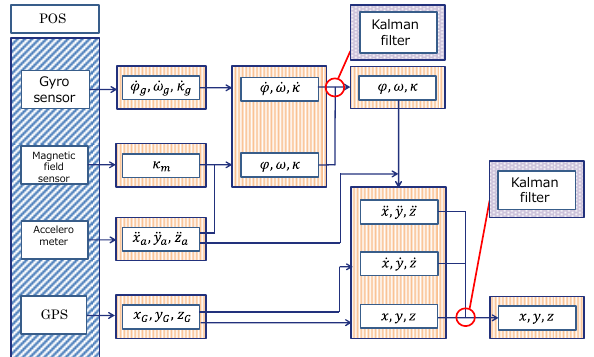
Figure 1. Flow of the POS data